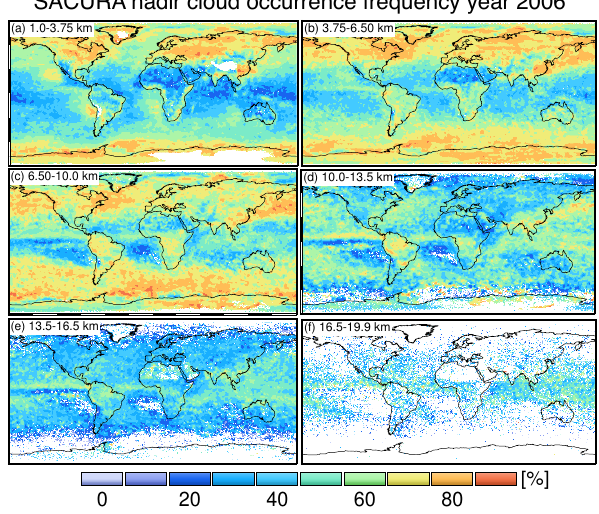
Figure 12. SCIAMACHY SACURA nadir cloud occurrence for the year 2006, projected on a grid of 2 ◦ -sided cells. From (a) to (f) val- ues are sorted in altitude layers as in Fig. 9. Due to the inherent conceptual difference between limb and nadir observation geom- etry, the occurrence is calculated averaging the actual nadir cloud fraction over time, resorting to the ergodic assumption by which space and time averages are equivalent.